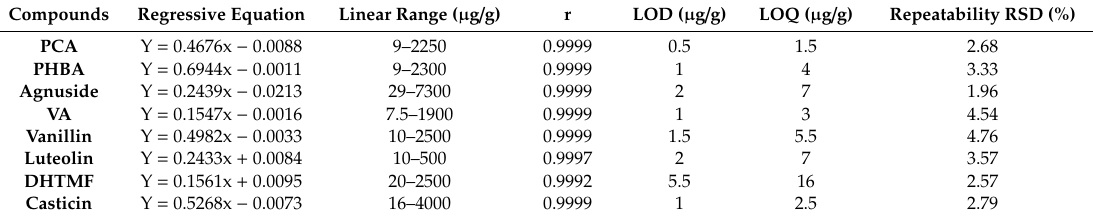
Table 1. Linearity, LOD, LOQ and repeatability of the proposed method ( n = 6). Compounds Regressive